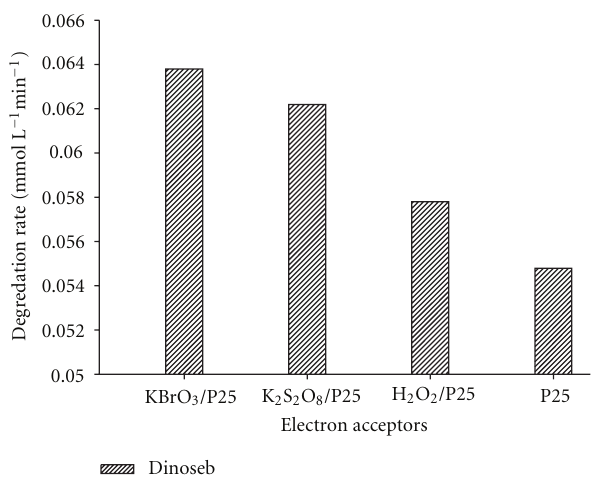
Figure 7: Comparison of degradation rate of Dinoseb in the pres- ence of various electron acceptors like H 2 O 2 , KBrO 3 , and K 2 S 2 O 8 . Experimental conditions: electron acceptor: H